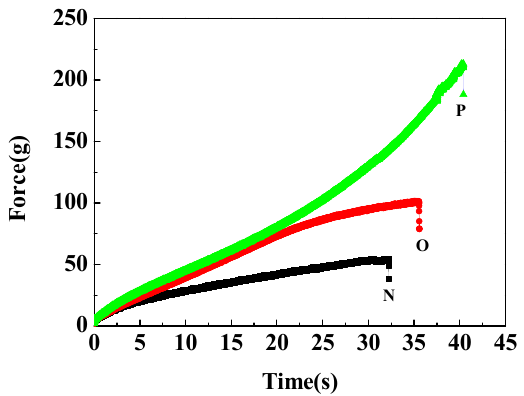
Figure 4. Stretching curves of hydrogels: normal hydrogel (N), hydrogel containing ordinary microspheres (O), and hydrogel containing polymerizable microspheres (P).